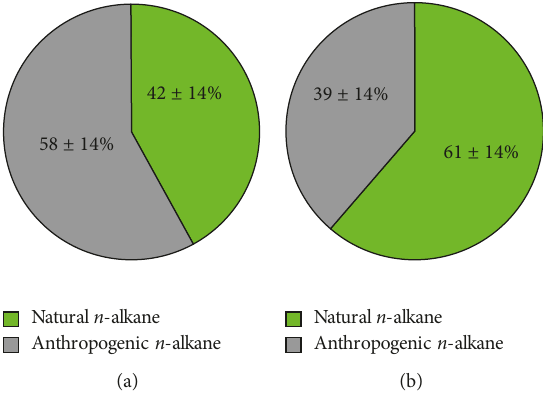
Figure 4: Mean percentage ± standard deviation of plant wax originated and petroleum originated particulate n -alkanes at Hamilton and Simcoe during SONTAS 2000.